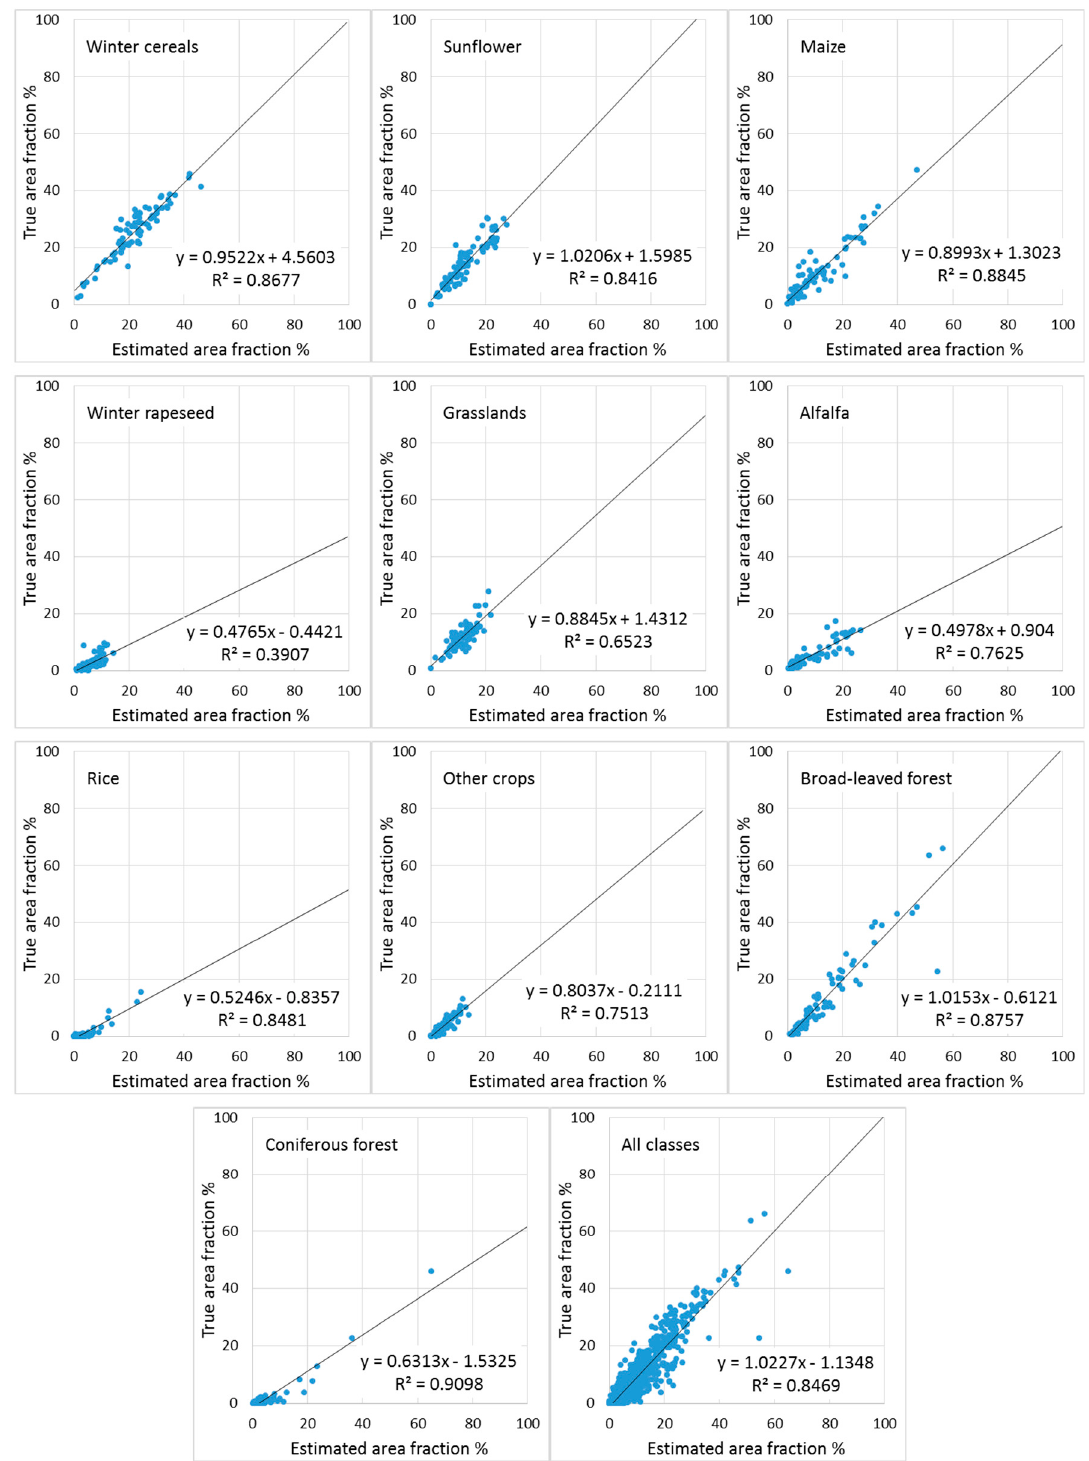
Figure 7. Scatterplots showing the correspondence between true and ANN estimated area fractions at regional level. The dots represent the averages for the artificial 10 × 10 km² regions as depicted in Figure 1. N = 80, except for the scatterplot for “All classes”, where N = 800.